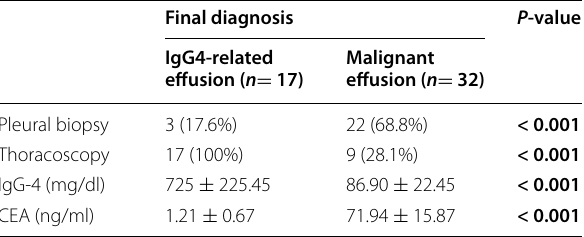
Table 7 The procedures and serum levels of IgG‑4 and CEA in